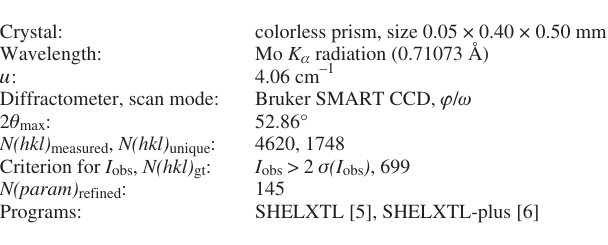
Table 1. Data collection and handling.